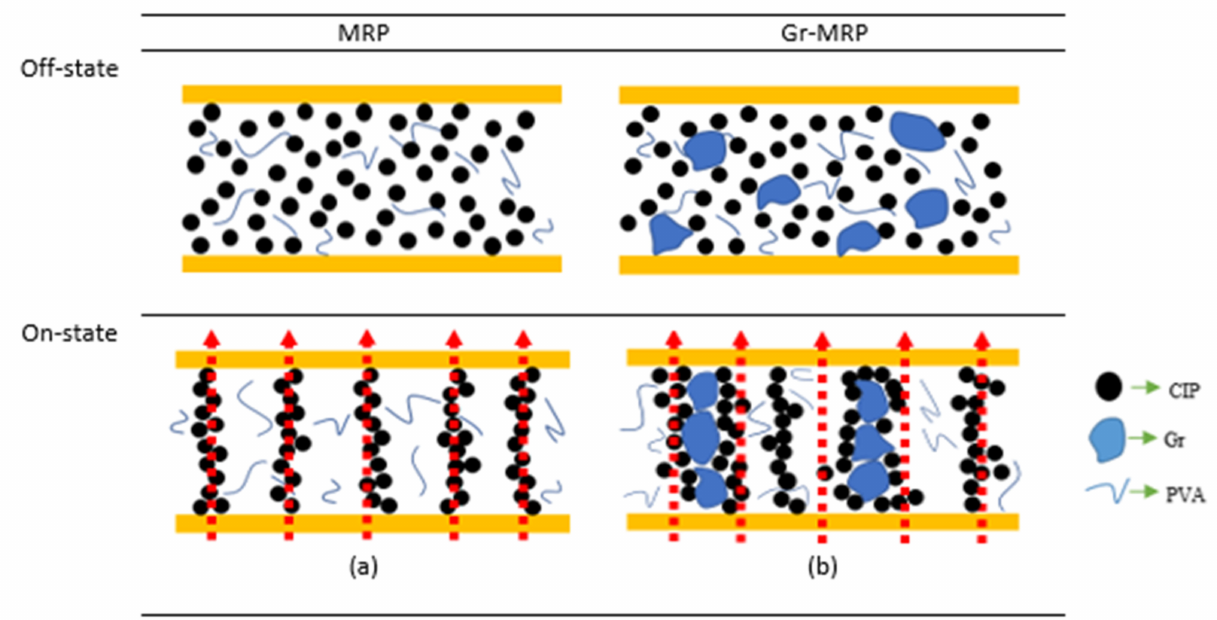
Figure 8. Illustration of magnetoresistance phenomena during the off-state (absence of magnetic field) and on-state (presence of magnetic field) conditions for ( a ) MRP and ( b ) Gr–MRP samples. Red arrow represents the direction of magnetic